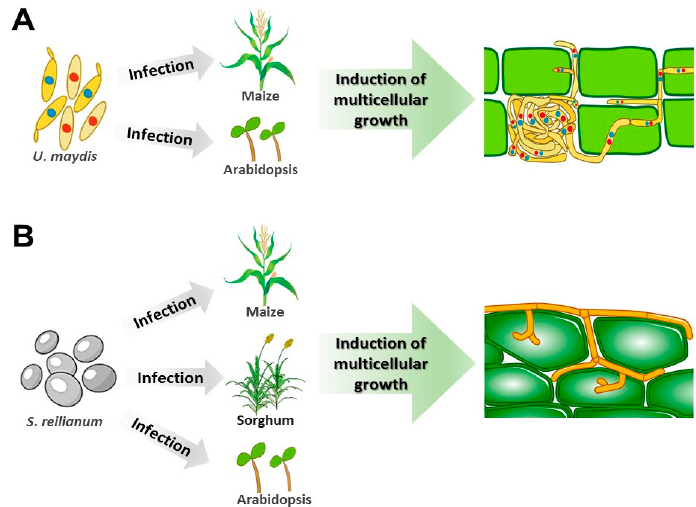
Figure 2. Multicellular growth of Ustilaginomycetes is induced during infection and colonization of the host plants. ( A ) Multicellular growth of Ustilago maydis as a filament is induced during the maize and Arabidopsis experimental host infection [27,63,64]. The di ff erent colors in sporidia nuclei represent di ff erent yeast-like cells that are sexually compatible. ( B ) Similarly, Sporisorium reilianum multicellular growth is induced during maize, sorghum, and Arabidopsis infection